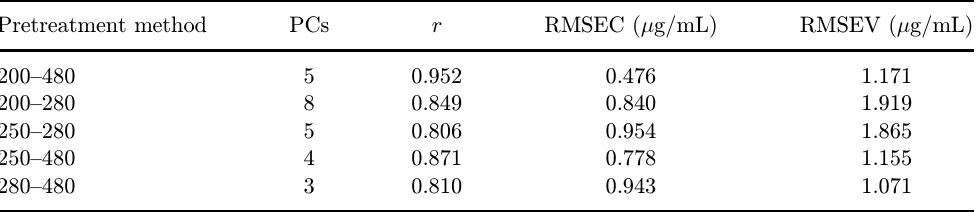
Table 5. Performance comparison of PLS regression models combined with di®erent band ranges.